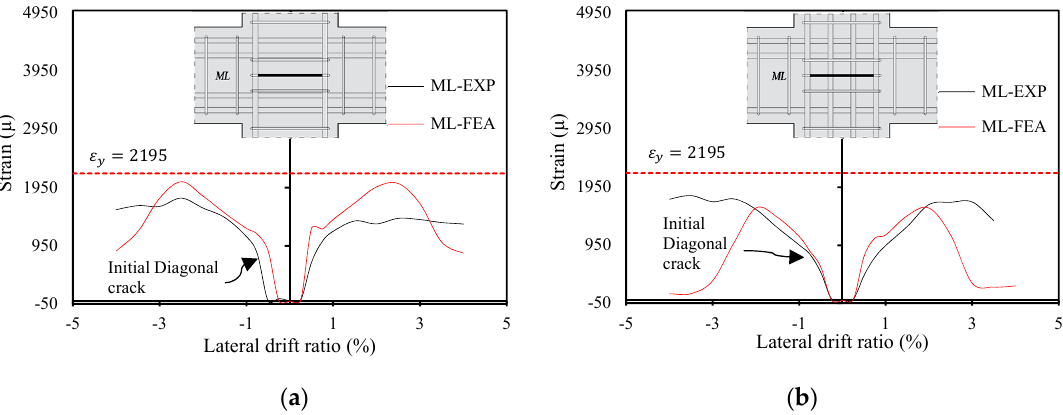
Figure 13. Strain development of the joint shear reinforcement: ( a ) S13-34 and ( b ) U13-34.